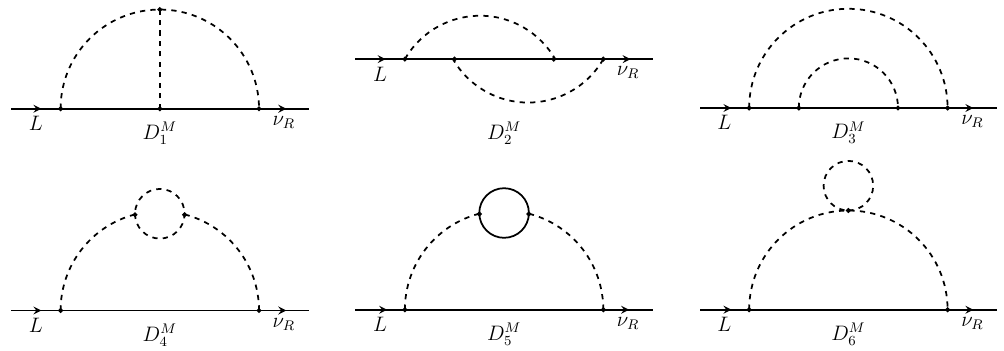
Figure 7 . List of diagrams in the mass basis. Note that after removing the external Higgs line, there is no one-to-one correspondence between the diagrams in the gauge basis ((cid:12)gures 3, 4 and 6) and the mass diagrams given